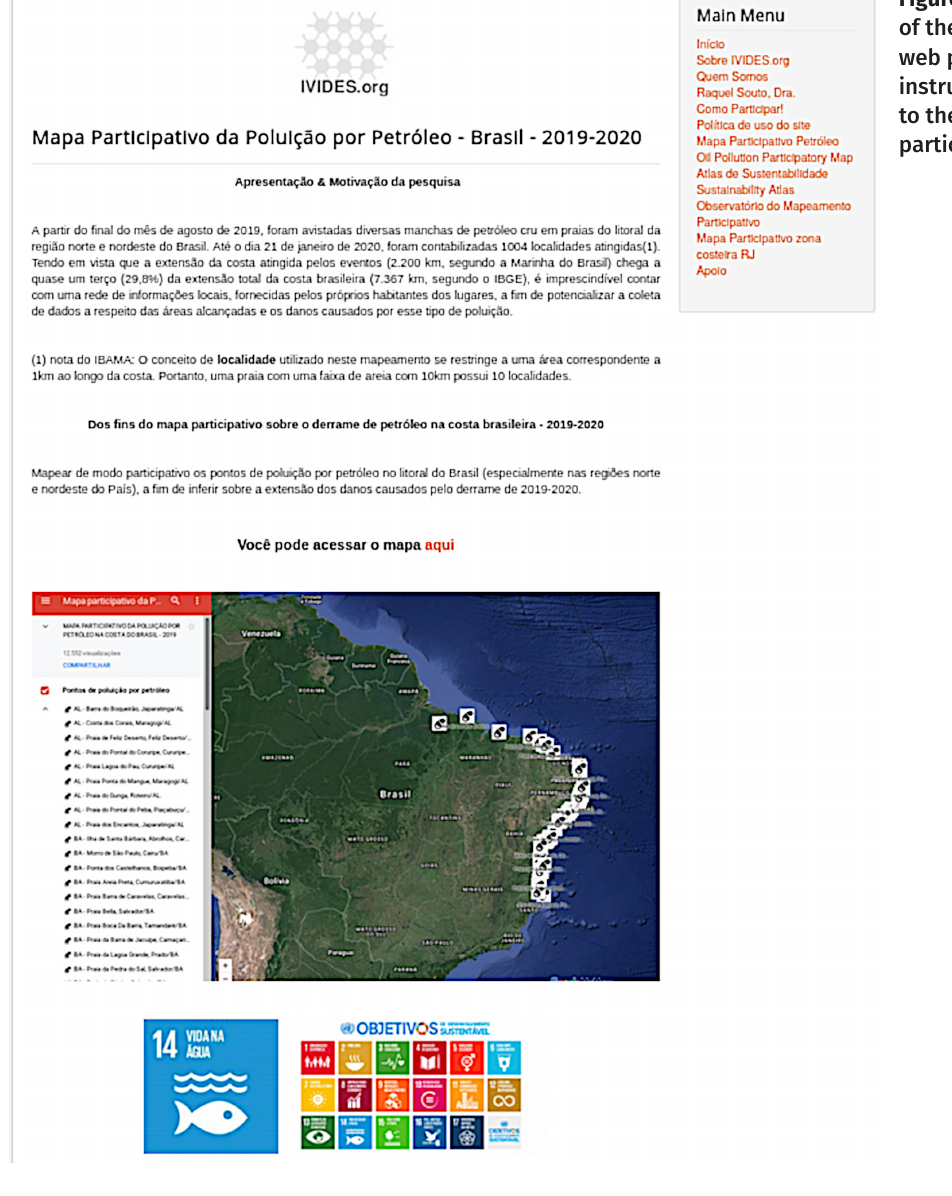
Figure 2. Capture of the project’s web page with instructions to the public